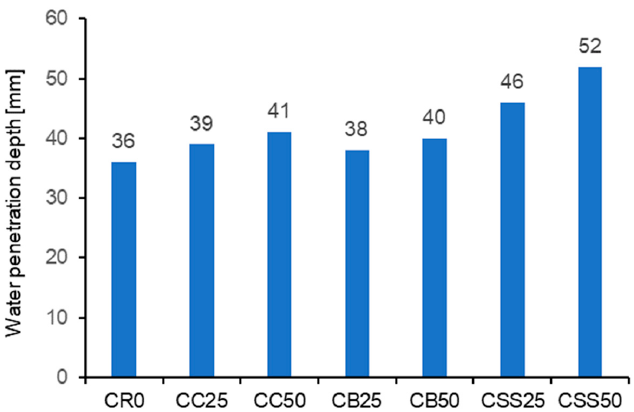
Figure 11. The results of testing maximum water penetration depth under pressure.